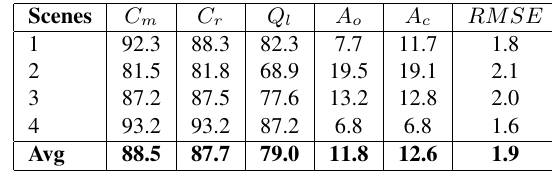
Table 8: Pixel-based evaluation results for December data set for the generated map from the automatically extracted